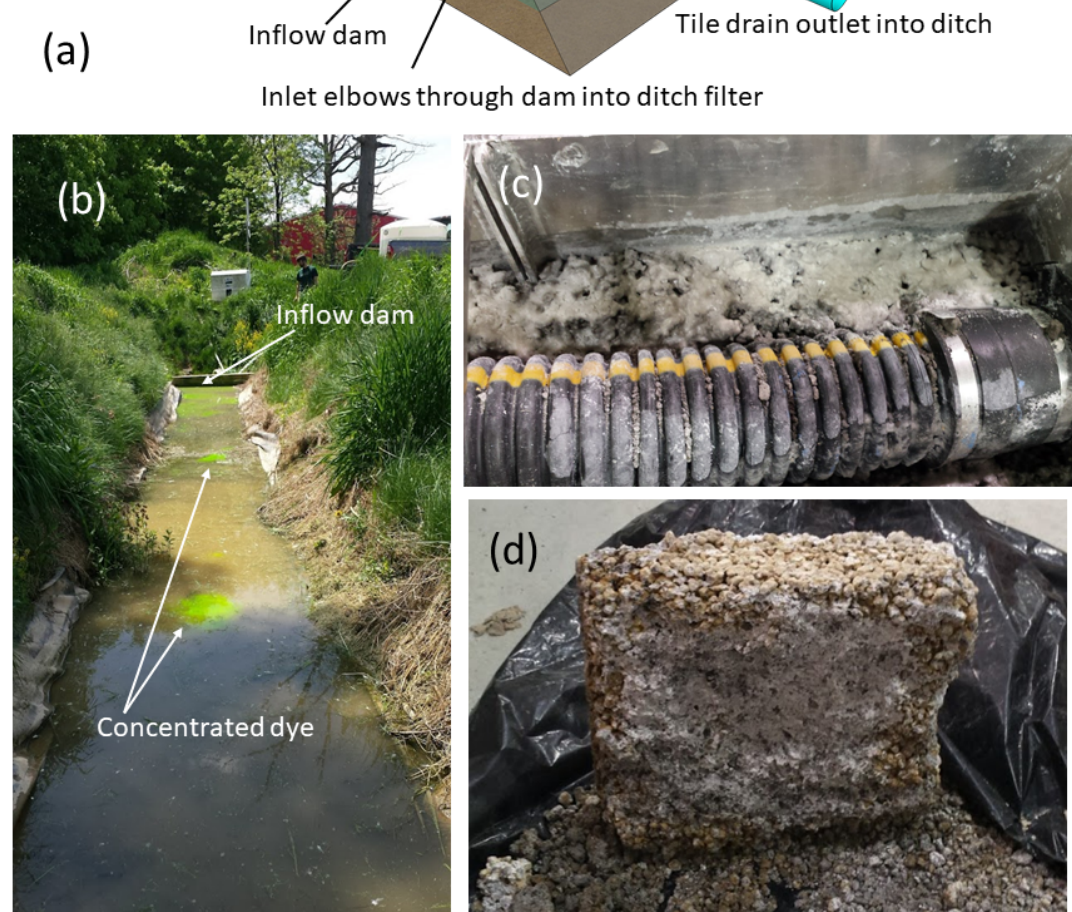
Figure 2. Schematic of the ditch phosphorus removal structure ( a ) and photograph taken during a dye test ( b ) illustrating the lack of uniform flow through the slag media and clogging of the ditch structure. Photograph ( c ) shows the flocculant/precipitant that forms through the dissolution and reprecipitation of calcium minerals that can fill the slag matrix and reduce pore connectivity ( d ).